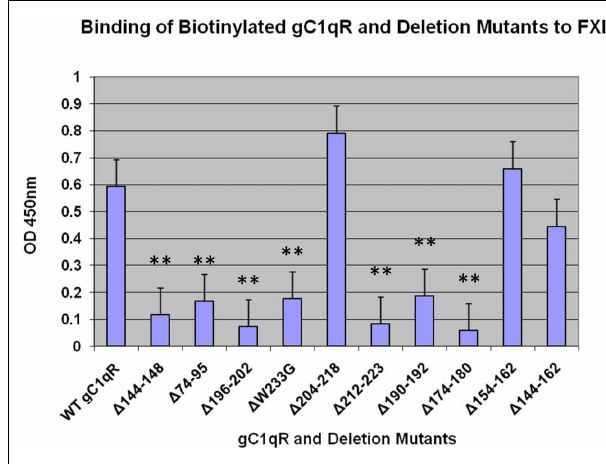
FIGURE 3 | Binding of biotinylated gC1qR mutants to of FXII. The experimental procedures are essentially as described in the Legend to Figure 1 . Each data point is a mean of three experiments run in duplicates with p values as described in the legends to Figures 1 and 2 .